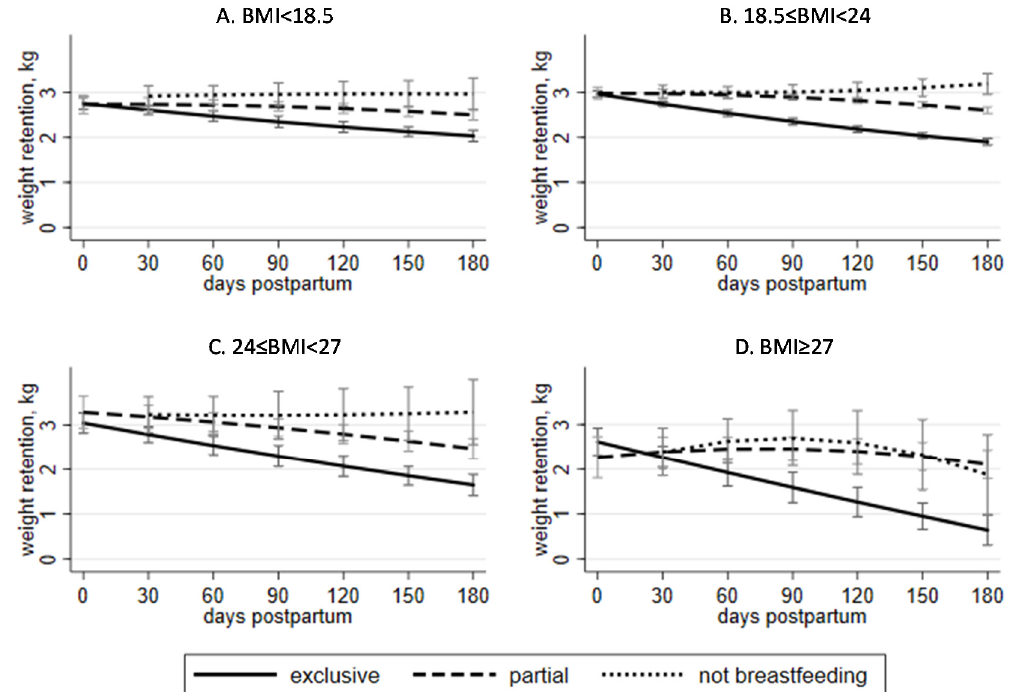
Figure 2. Adjusted means and 95% confidence intervals of postpartum weight retention and duration of breastfeeding in Taiwanese women by pre-pregnancy BMI ( N = 52,367): ( A ). underweight ( n = 8911), ( B ). normal ( n = 34,927), ( C ). overweight ( n = 5419), ( D ). obese ( n = 3110). Notes: (1) postpartum weight retention was assessed at 7–14 months postpartum; (2) X-axis represents duration of breastfeeding in days postpartum; (3) each time point on the same curve represents different women; (4) exclusively breastfeeding women that started adding food, liquids, or formula are represented at a later time point on the curve for partial breastfeeding; (5) sample sizes do not sum up to the total because of the cross-sectional design of the study; (6) sample sizes for each time point are available in the supplementary materials (Supplementary Table S2); (7) weight status categorized by BMI cutoffs for Taiwanese population—18.5, 24 and 27 kg / m 2 (Taiwan Health Promotion Administration. (2018). BMI classification (in Chinese). Retrieved from http: // health99.hpa.gov.tw / OnlinkHealth /